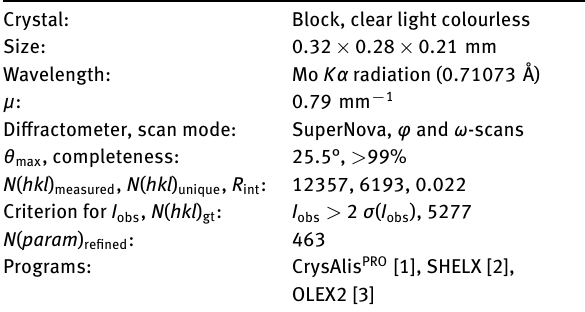
Table 1: Data collection and